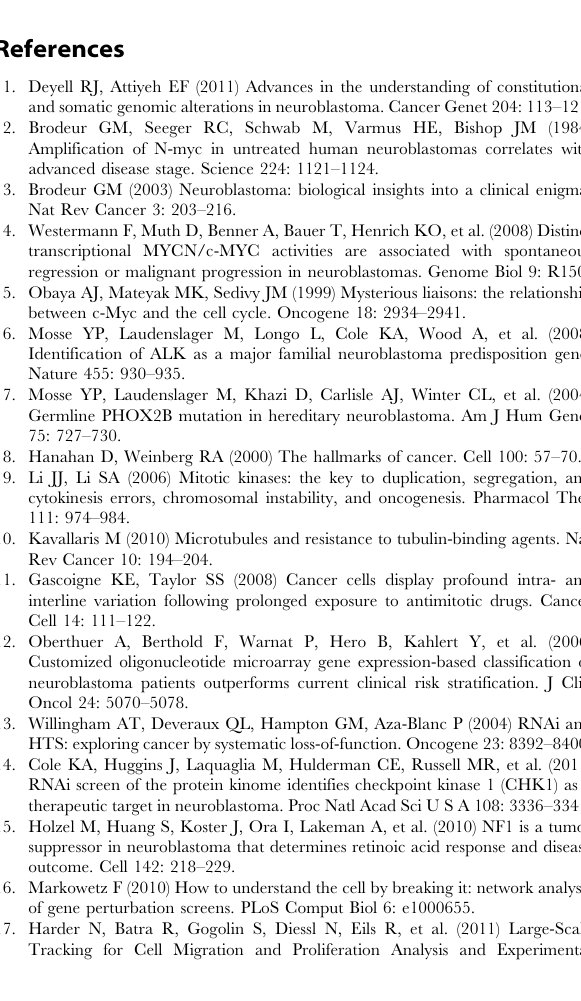
Table S5 Candidate genes with phenotype Cell death during or after mitosis. Table S6 Results of the gene expression analysis for the six identified genes. Table S7 Kinase families and their predicted substrates from our candidate